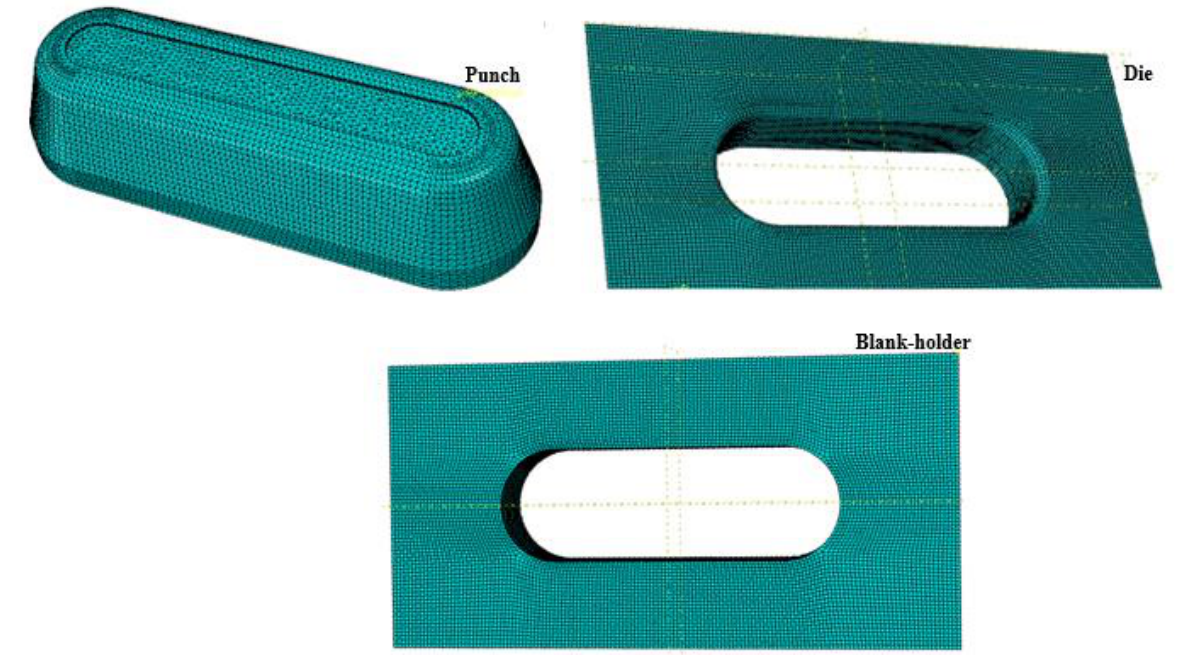
Mathematics 2022 , 10 , x FOR PEER REVIEW Figure 6. Die, blank-holder, and punch for the car fuel tank. Figure 6. Die, blank-holder, and punch for the car fuel tank.